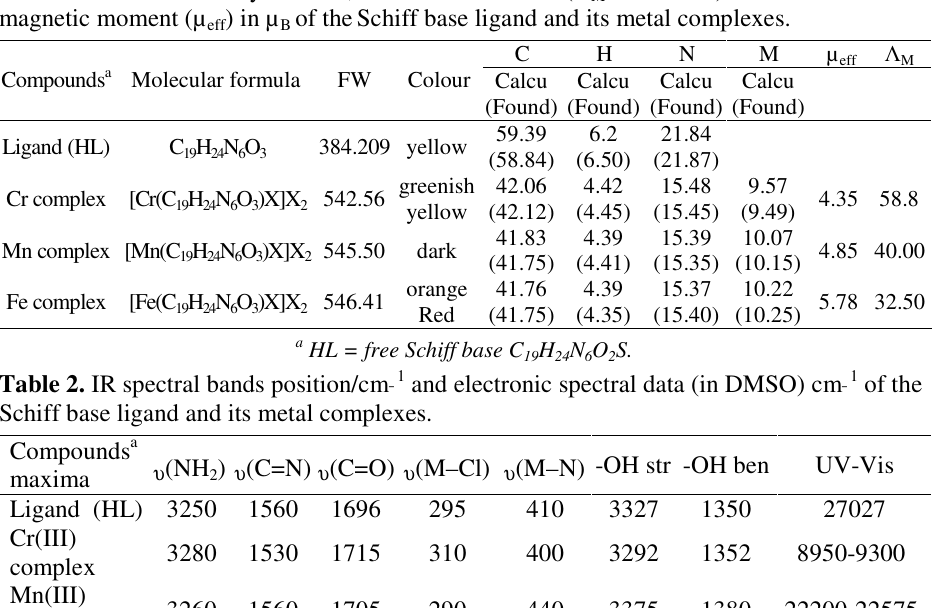
in DMSO) in S cm 2 mol -1 and M